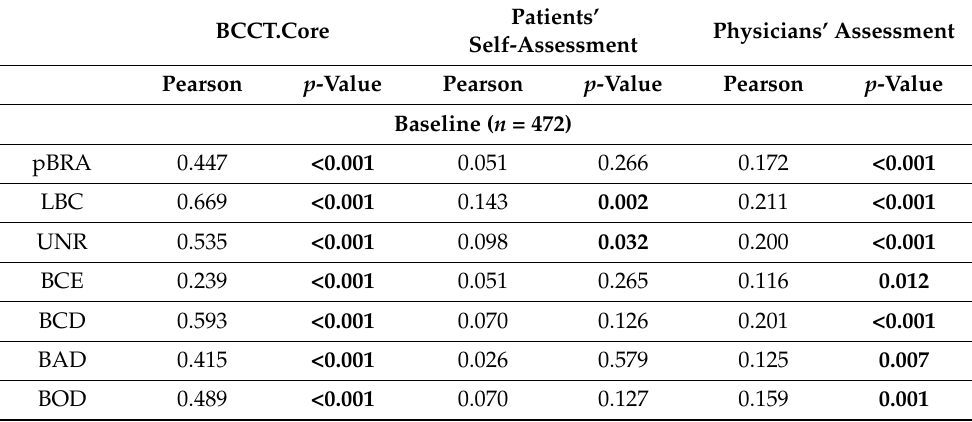
Table 2. Correlations between breast asymmetry indices and overall esthetic outcomes of BCCT.core, and between breast asymmetry indices and patients’ or physicians’ assessment scores, at the